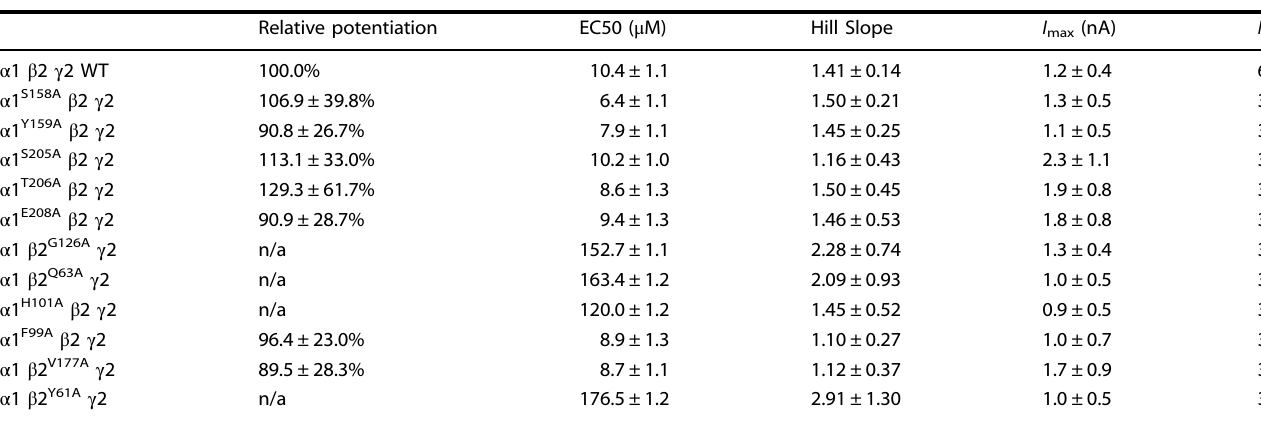
Table 1. Mutational analyses identifying the glutamate binding pocket at the α 1 + / β 2- interface of the α 1 β 2 γ 2 GABA A R a. Effects on glutamate potentiation by individual mutation of putative α 1 or β 2 amino acid residues forming the loop C pocket (P1; see Supplementary Fig.